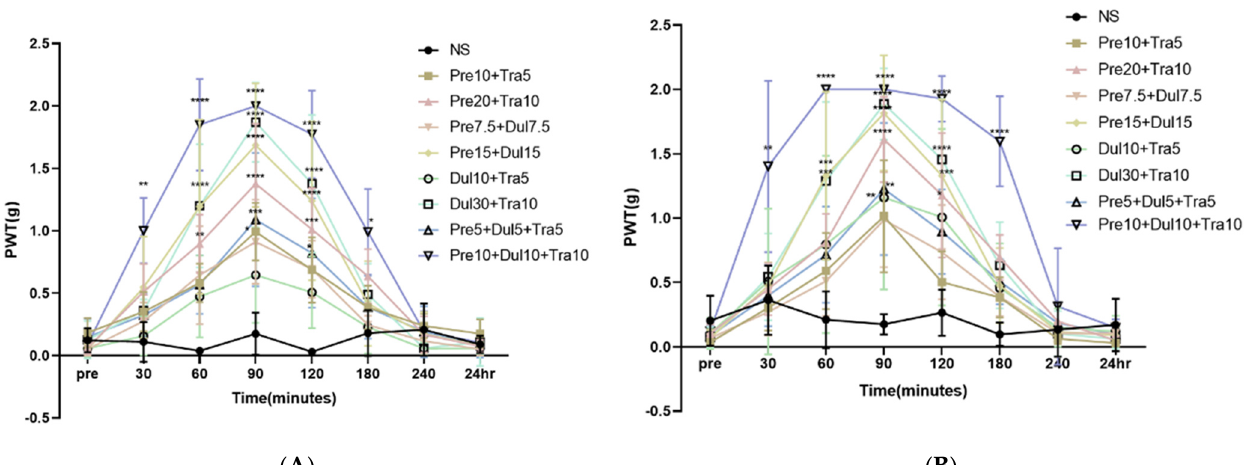
Figure 2. The effect of mixed administration of pregabalin + duloxetine + tramadol on the tactile threshold of CPIP and SNL mice. ( A ) Compared with the control group, drug injection can reduce the mechanical allodynia of CPIP mice in a dose-dependent manner. pregabalin10 mg/kg + duloxetin10 mg/kg + tramadol10 mg/kg injection group has the best relieving effect on mechanical allodynia. ( B ) The mechanical allodynia of the mice in each group injected with the drug was significantly reduced. pregabalin10 mg/kg + duloxetine10 mg/kg + tramadol10 mg/kg group has the strongest relieving effect on mechanical allodynia and continued effective ( n = 4 in NS group, n = 6 in other treatment groups). NS, normal saline; Pre, pregabalin; Dul, duloxetine; Tra, Tramadol; CPIP, chronic post-ischemic pain; SNL, spinal nerve ligation. * p < 0.05, ** p < 0.005, *** p <